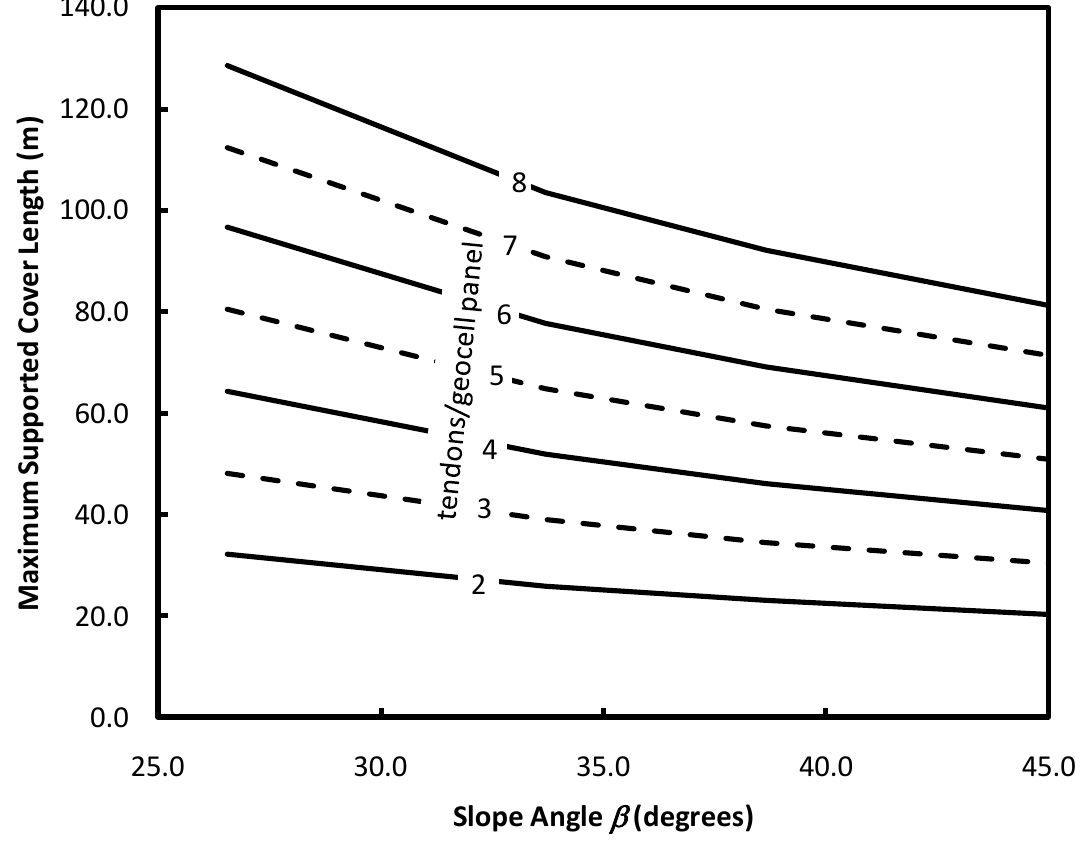
Figure 10. Example design chart showing maximum slope length for different slope inclinations and number of tendons per 2.55-m wide geocell panel.